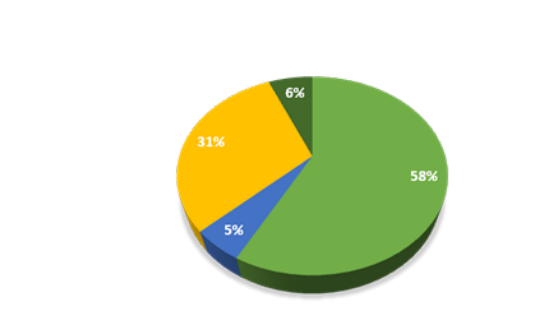
Table 2. Accident indicators.